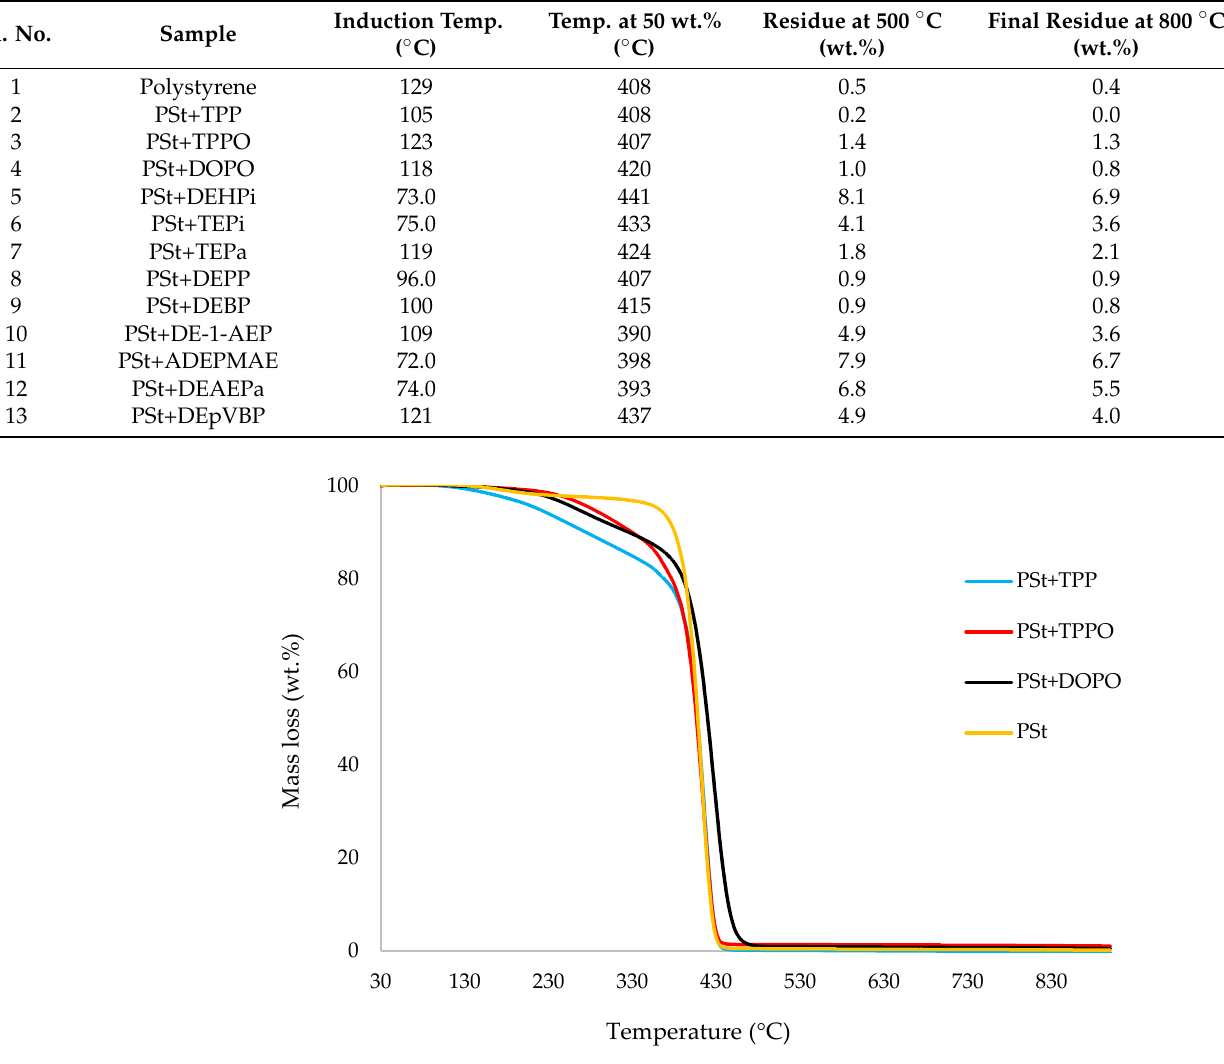
Figure 1. An overlay of the TGA curves of the PSt-based materials with solid additives, at 10 °C min −1 in nitrogen, from 30 to 900 °C.